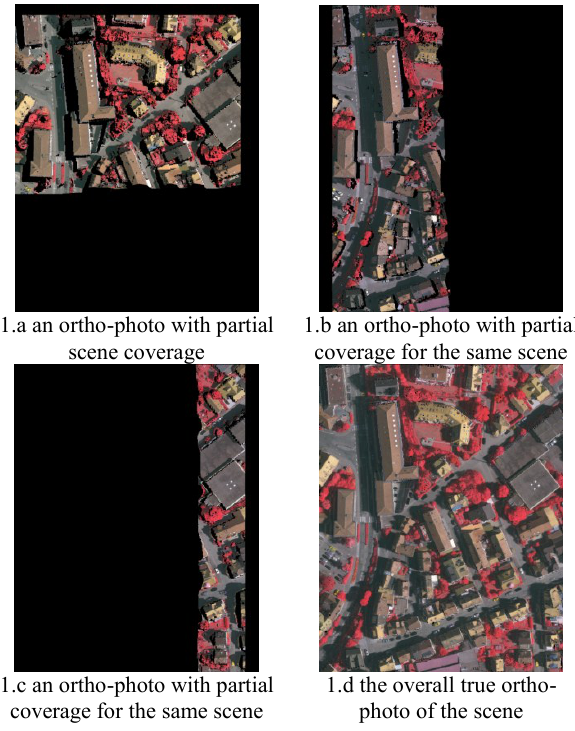
Figure 1. True ortho-photo generation Normalized Difference Vegetation Index (NDVI) is computed for all objects in the scene using IR and R bands of the generated true ortho-photo as in